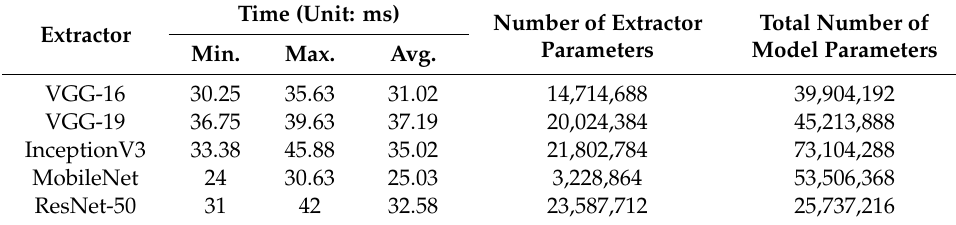
Figure 17. Validation accuracy for different CNN-based networks. Table 6. Comparison of di ff erent models for pattern